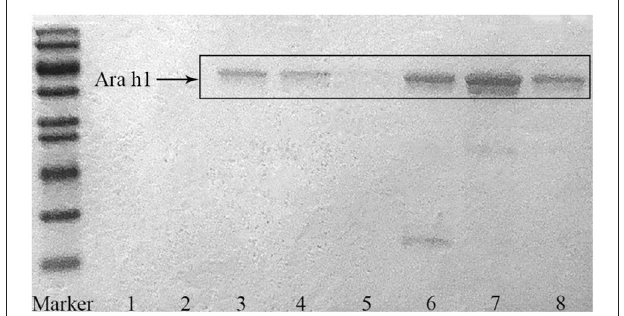
FIGURE 1 | SDS-PAGE of the purified Ara